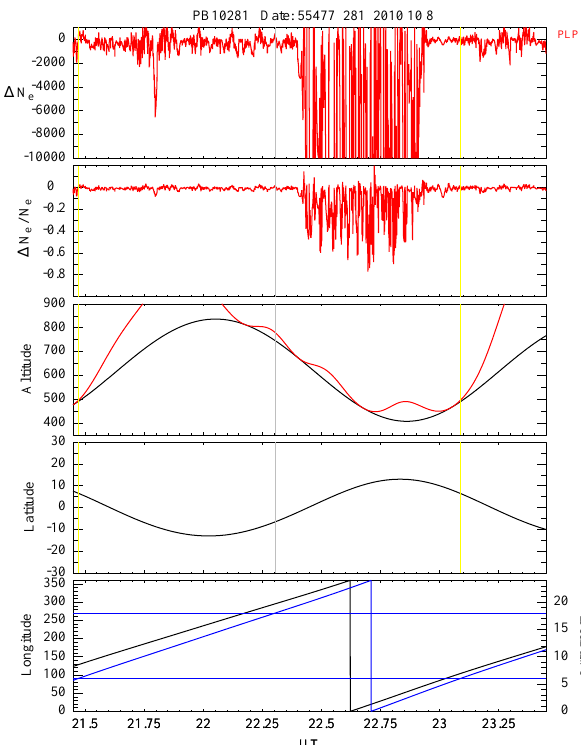
Fig. 3. The plasma density perturbation observed by PLP onboard the C/NOFS satellite on day 282 of 2010, at around 22 UT. The top panel gives the density perturbation (red curve, in number percm 3 ) determined by high-pass filtering of the observations. The second panel gives the density perturbation normalized by the ambient den- sity. (The gray lines in these panels mark the time of 18:00LT, the yellow lines the time of 06:00LT.) The third panel gives the alti- tude of the satellite at the time of the observation (black curve) and the apex altitude of the observation point mapped back to the geo- magnetic equator (red curve). The fourth panel gives the latitude of the observation, while the bottom panel gives the longitude (black curve, left-hand scale) and local time (blue curve, right-hand scale) of the